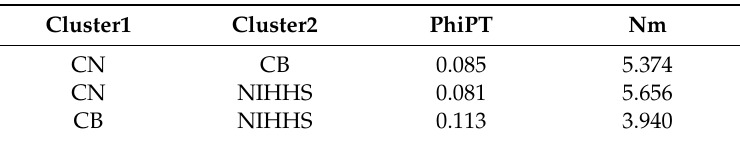
Table 4. Pairwise cluster PhiPT values and Nm values based on 999 permutations from AMOVA according to conservation institutes (all PhiPT values were significantly greater than 0, p <